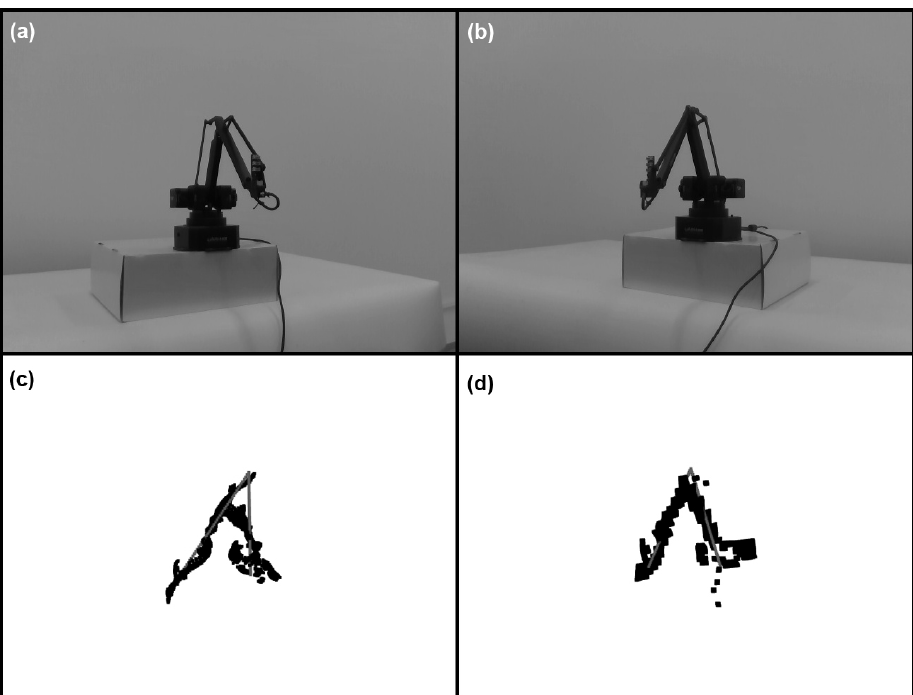
Figure 5. Transformation to the coordinate system independent on the camera. View of the same frame: ( a ) left camera view, ( b ) right camera view, ( c ) point cloud obtained from the left camera after projection and ( d ) Point cloud obtained from the right camera after projection. Table 2. Influence of the number of points used in the k –means algorithm ( N kmeans) and the number of intermediate points in the graph ( N graph) on time and computation quality. (err α means the mean absolute error for each alpha in comparison to the real settings, err α is the mean error for three